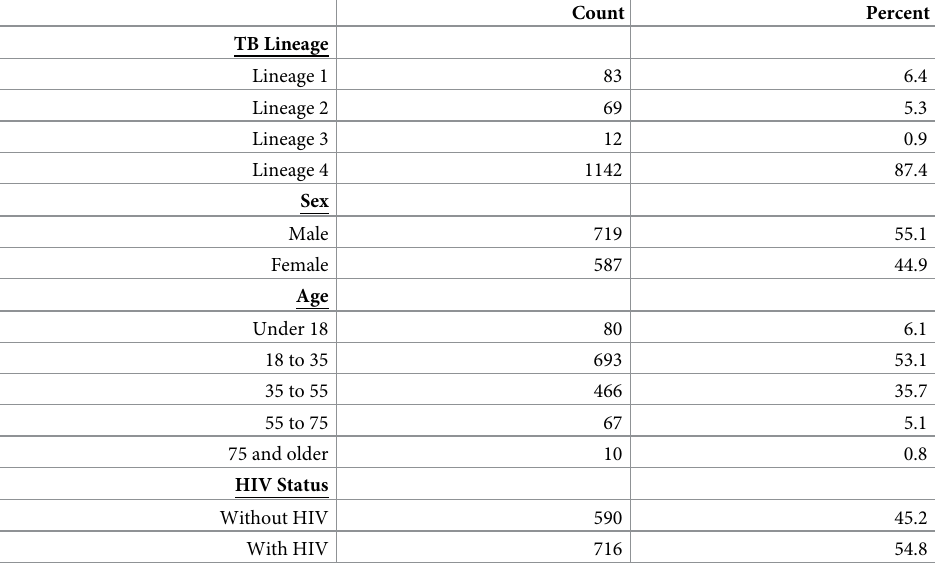
Table 2. Study participant characteristics. Summary statistics of participant characteristics from the study of M. tuberculosis in